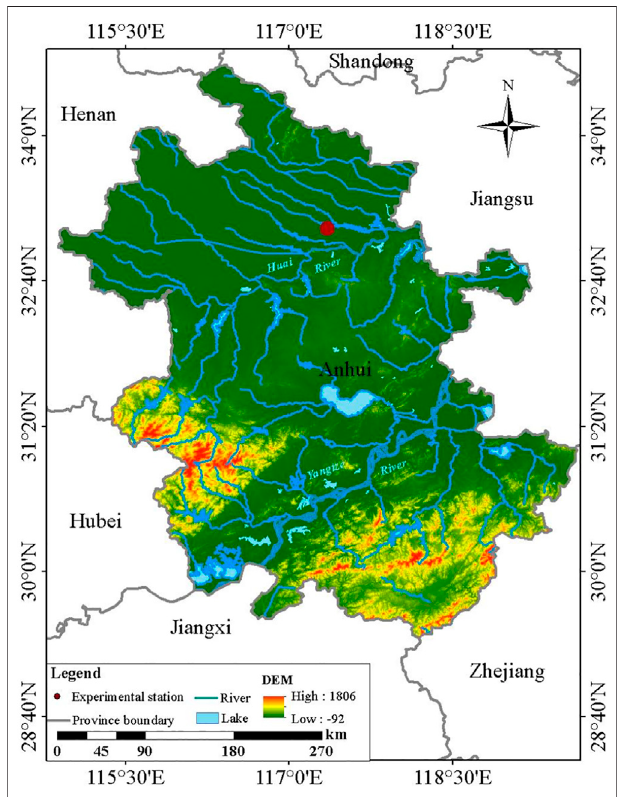
FIGURE 2 | The location of the experiment site and its